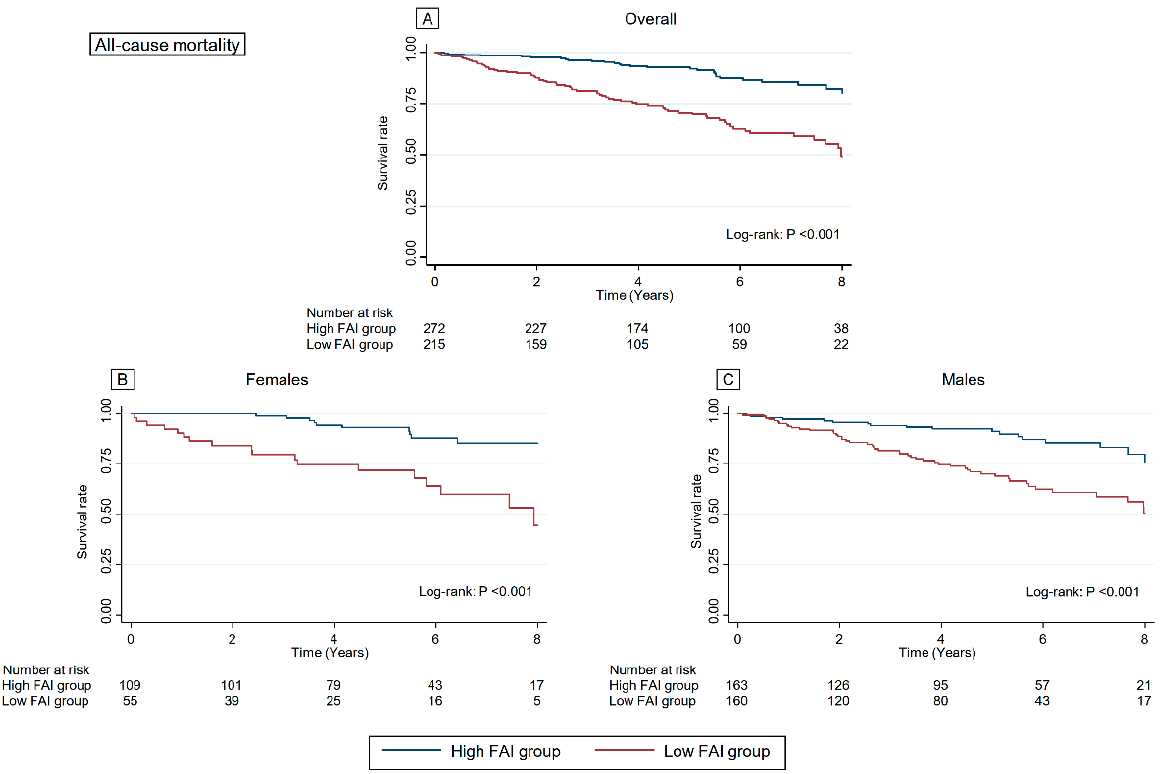
Figure 3. Kaplan–Meier curve for all-cause mortality according to the FAI in the overall cohort, females, and males. The all-cause mortality was significantly higher in the low FAI score group than those in the high FAI score group in the overall cohort ( A ), females ( B ), and males ( C ). FAI, Frenchay Activities Index.